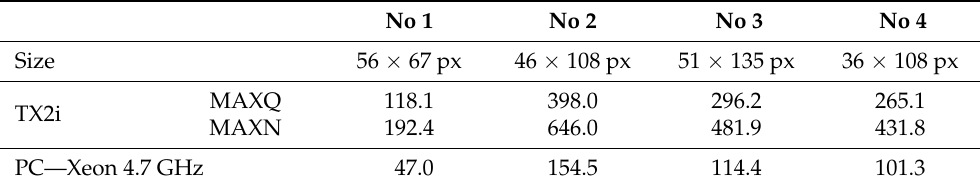
Table 5. Subimages’ classification times, in µ s